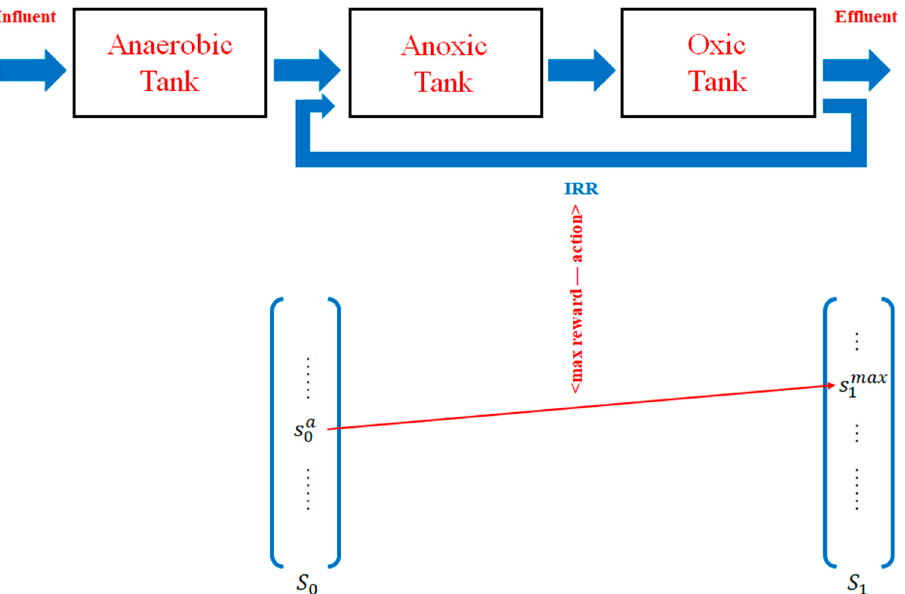
Figure 5. Simplified mapping function for IRR optimization in AAO system by an integrated ASM- QL